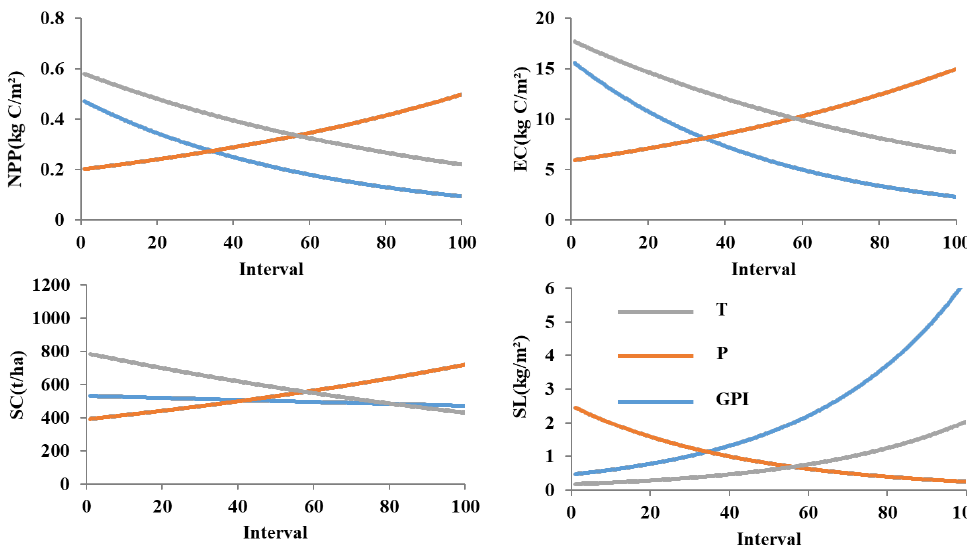
Figure 9. Impacts of climate change and grazing pressure on ecosystem services. T, temperature (°C); P, precipitation (mm); GPI, grazing pressure index; NPP, net primary production (kg C/m 2 ); EC, ecosystem carbon (kg C/m 2 ); SC, soil conservation (t/ha); SL, soil loss by wind (kg/m 2 ).